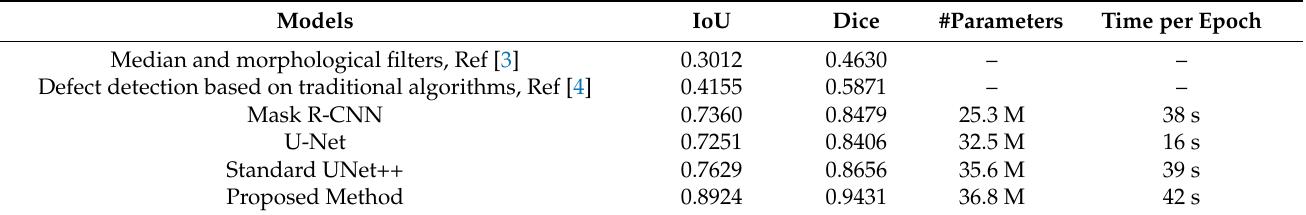
Table 5. The performance of the all the selected segmentation method over the test set—DSXImage database. Models Dice Median and morphological filters, Ref